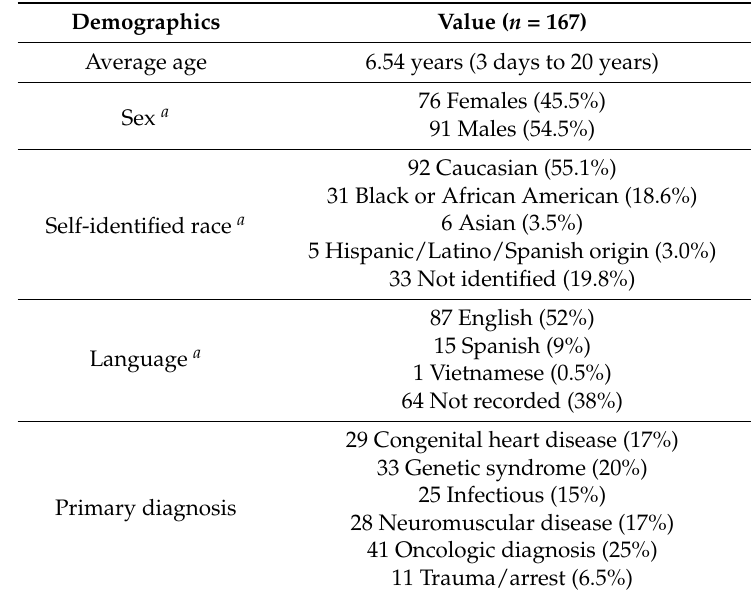
Table 1. Baseline patient characteristics and demographics.